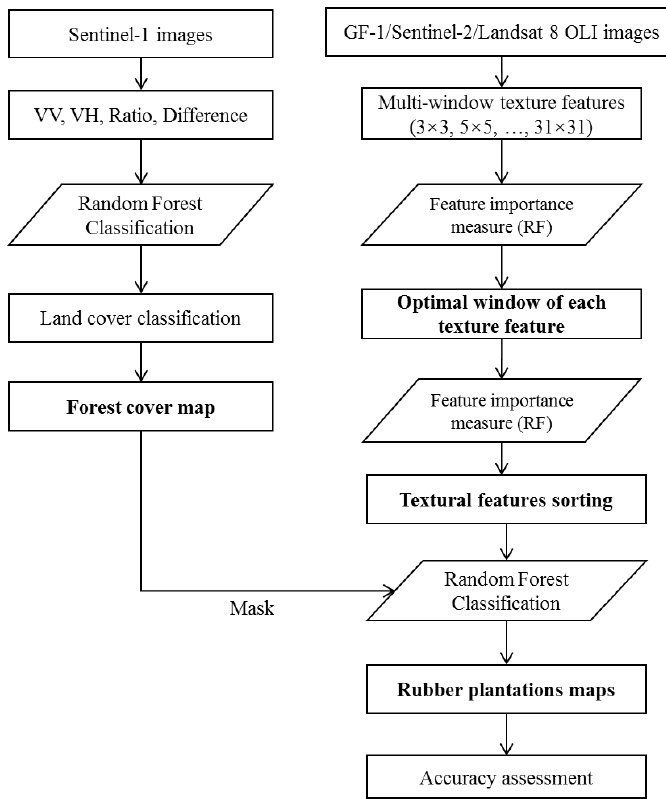
Figure 2. Flow chart for the method proposed in this study.